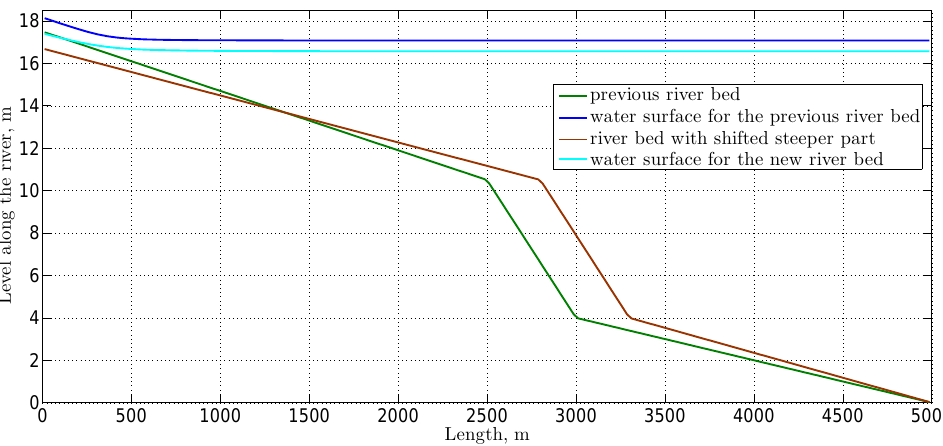
Figure 13: Two different river geometries, together with initial water